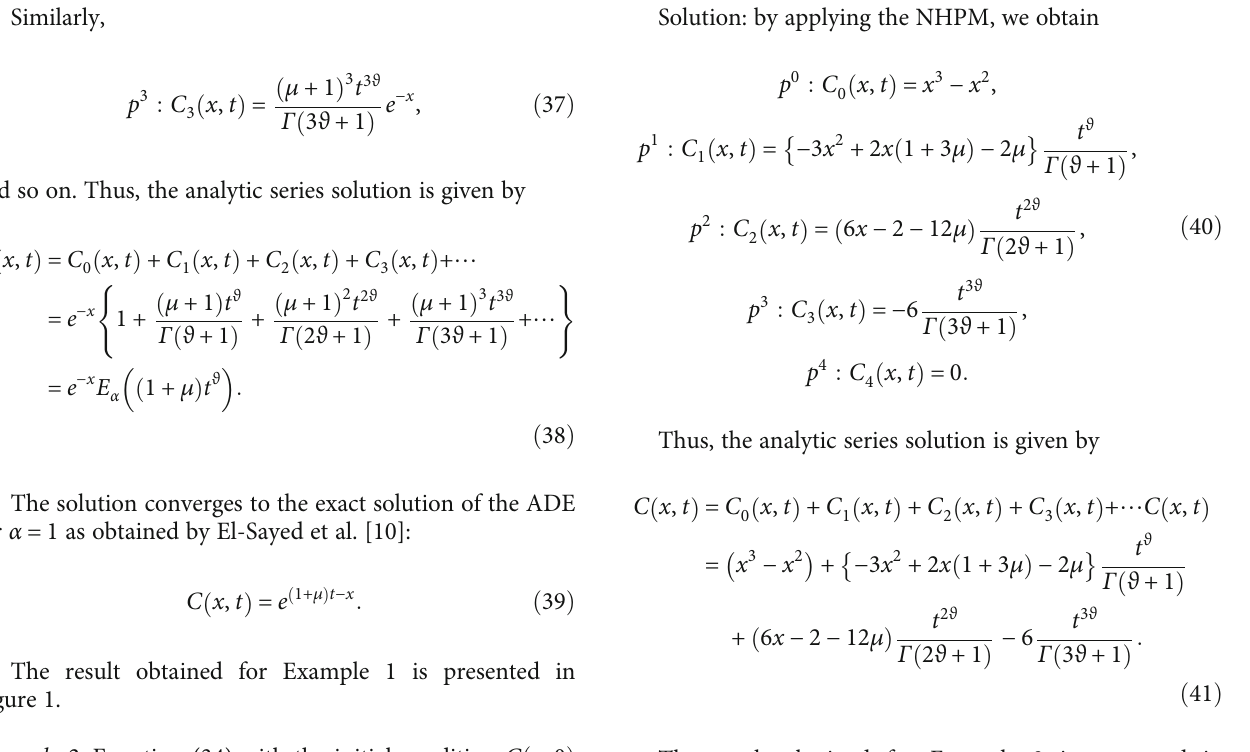
Figure 2: Variation of the concentration C ð x , t Þ with the fractional parameter α for μ = : 01